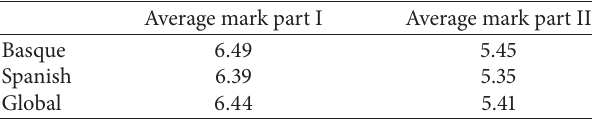
Table 3: Average mark (0 to 10 scale) in each part of the